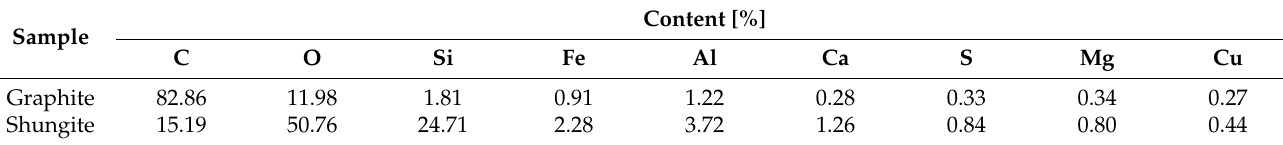
Table 1. Composition of carbonaceous